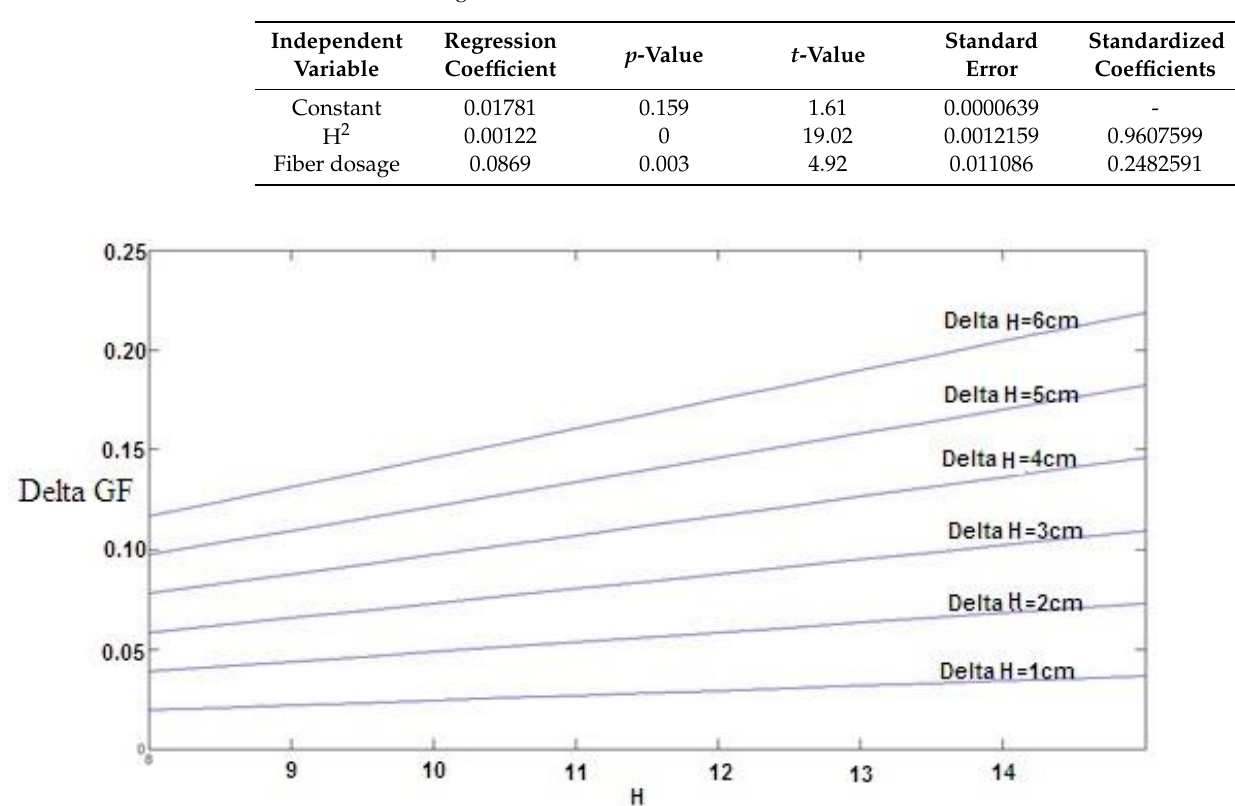
Table 4. Values of regression coefficients of G F .